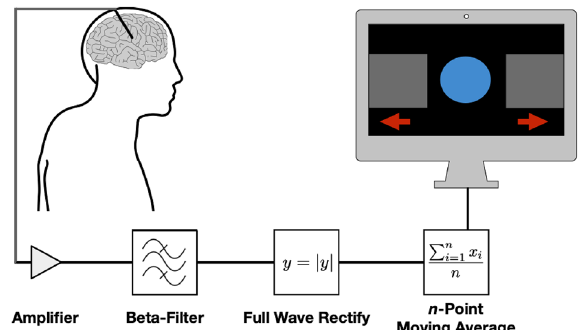
Figure 1. Deep brain electrical neurofeedback loop. Deep brain stimulation electrodes (upper left corner) implanted into the subthalamic nucleus allowed for brain oscillation measurements. The raw, analogue signal was amplified and then digitally band-pass filtered around the individual beta-peak (± 5 Hz), rectified, averaged and used to control the position of the blue disc on the monitor (upper right corner). Patients tried to volitionally control the position of the disc, thereby closing the neurofeedback loop while controlling pathological